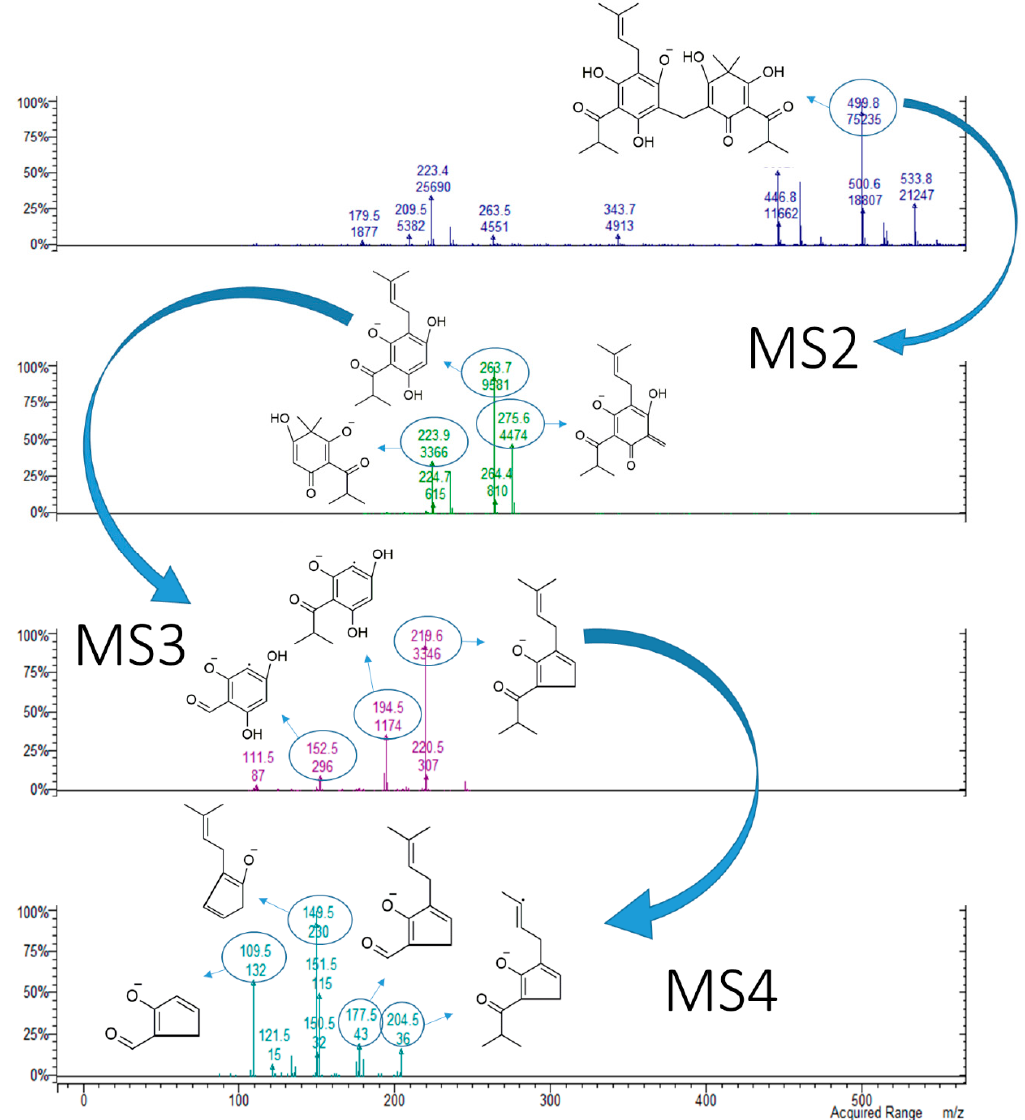
Figure 6. MS n ( n = 4) spectra of compound 9 (uliginosin A), [M-H] − = 499. The structures of the fragments associated with the main peaks are